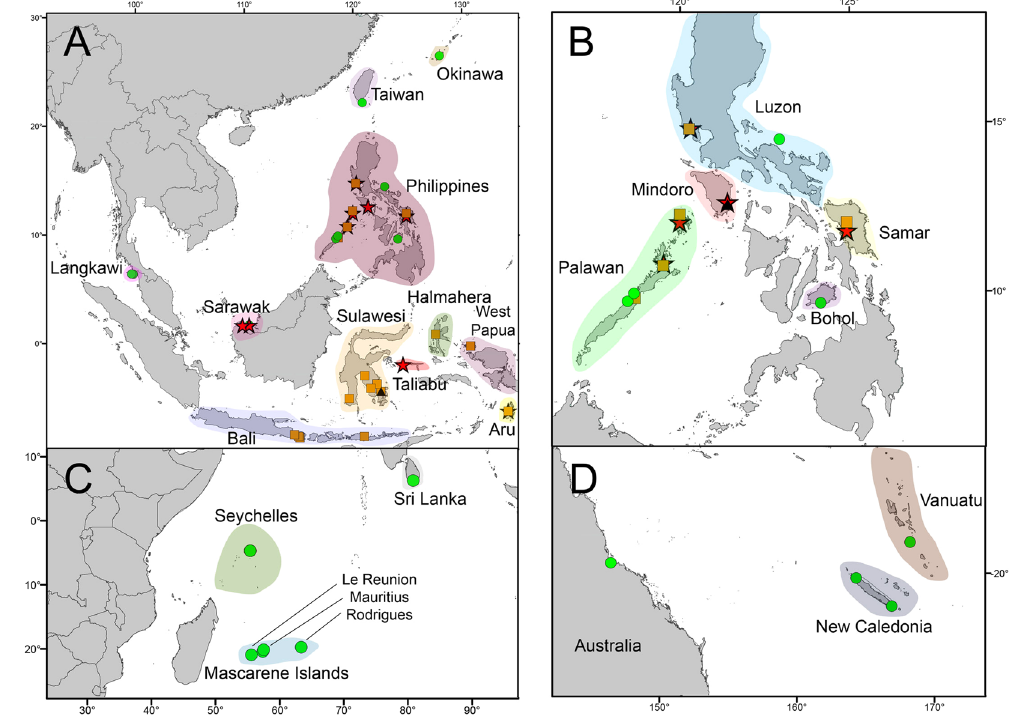
Figure 1. Sampling map of the Indo-Australian Archipelago (IAA) and Eastern Asia ( a ), with detail for Philippine islands ( b ); Western Indian Ocean ( c ) and South Pacific ( d ). The colours represent the regions and the symbols illustrate the three major clades (putative species): stars represent TAL, circles represent ARC and squares represent SUL. The triangles represent the other Caridina samples, C . villadolidi and C . opaensis . Map and georeferencing were generated through ArcGIS Desktop: Release